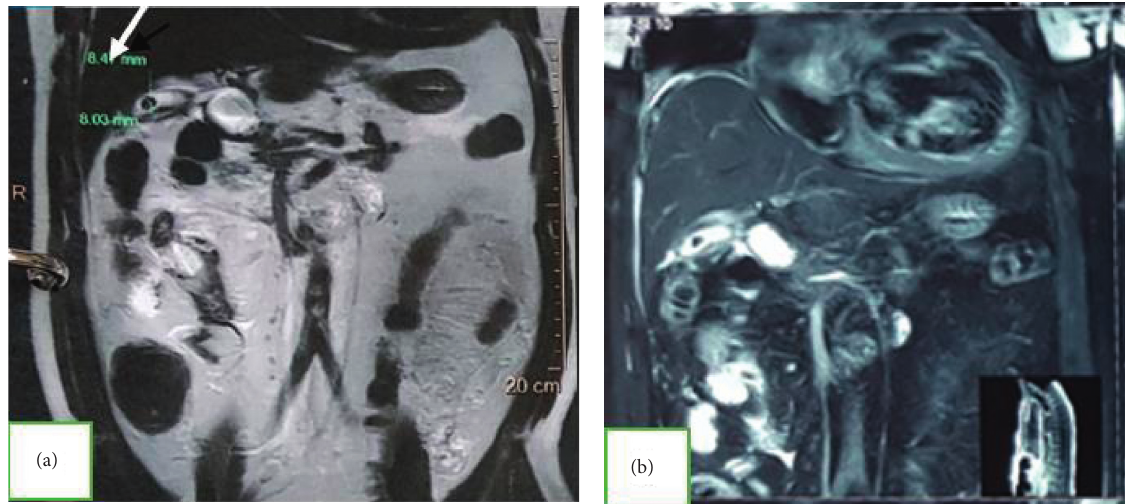
Figure 3: Abdominal MRI: (a) gall bladder with the stone inside (arrow) and free peritoneal fluid; (b) no dilatation of the intrahepatic bile duct (IHBD) and extra hepatic bile duct (EHBD).